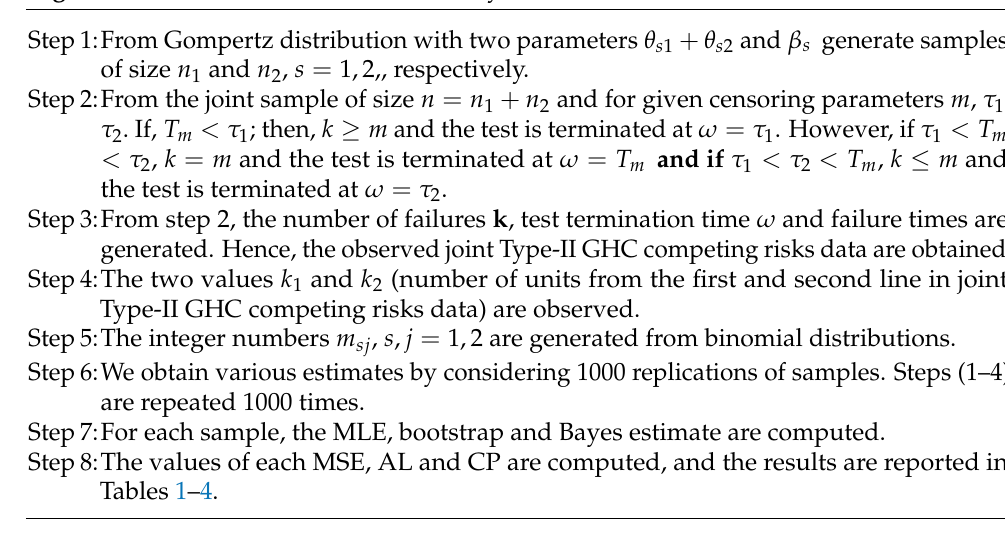
Algorithm 3 Monte Carlo simulation